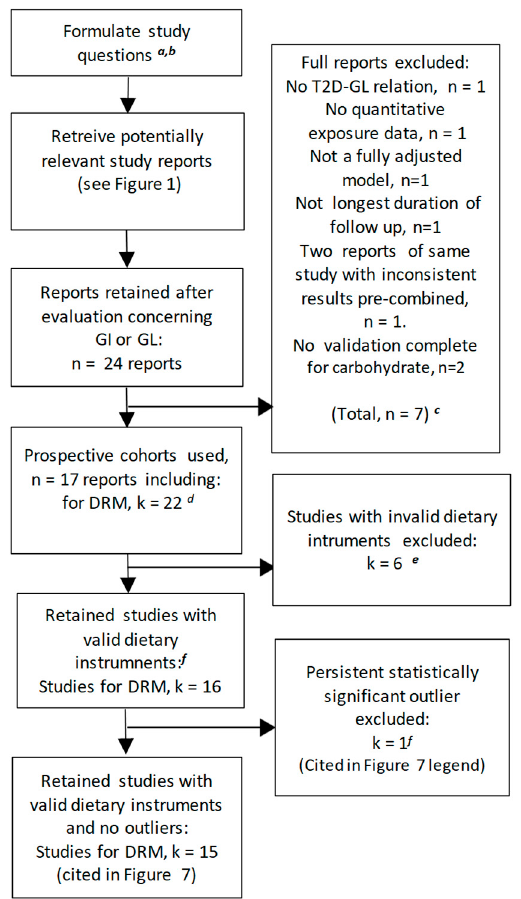
Figure 6. Process of the review and outcomes of the inclusion and exclusion criteria for the T2D–GL risk relation. Literature searches were for prospective cohort studies investigating this relation published in the period of 1946 to 6 December 2018 via MEDLINE and EMBASE and other sources—see the Methods section and Figure 1. Superscripts note: a . Whether T2D is related to the dietary glycemic load (GL) and whether the risk relation is > 1.20 with a lower confidence limit > 1.10 for each 10th to the 90th percentile of GL intake (which, on analysis, was per 80 g GL in 2000 kcal (8400 kJ)? b . Is the T2D–GL risk relation conditional on the validity of the dietary instrument for carbohydrate, on the sex of the participants, or on the BMI (kg / m 2 ), and was the T2D–GI risk relation conditional on protein intake [10] and / or alcohol (ALC) intake [40]? c . Details of the full reports excluded are described in the associated text and in more detail in Section 3 (h to l) of the Supplementary Materials. d . Studies used (n = 22) in the meta-analysis with multiple covariates. e . Studies were invalid if the dietary instrument had a correlation coe ffi cient for carbohydrate foods ≤ 0.55. f . When a study suspected of being an outlier in a forest plot was proven to be so upon meta-regression analysis ( p < 0.05) and persisted to be so in several di ff erent meta-analyses (Table S15), it was excluded. Abbreviations: DRM, dose-response meta-analysis; GL, glycemic load; n, number of published reports; k, number of studies (more than one may appear in one report); T2D, type 2